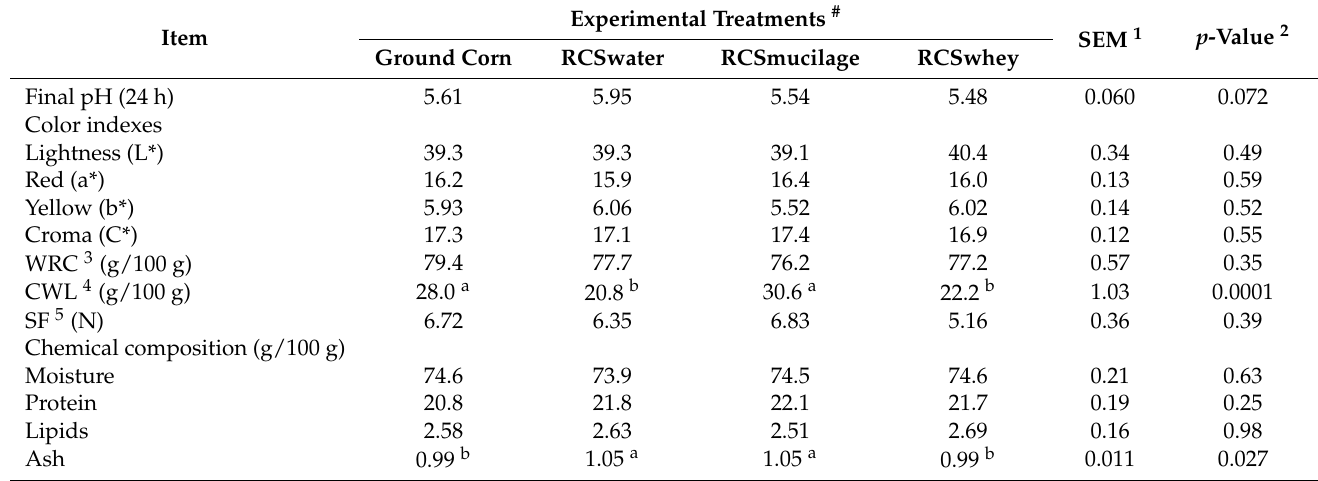
Table 4. Chemical composition and physical properties of the longissimus lumborum muscle of